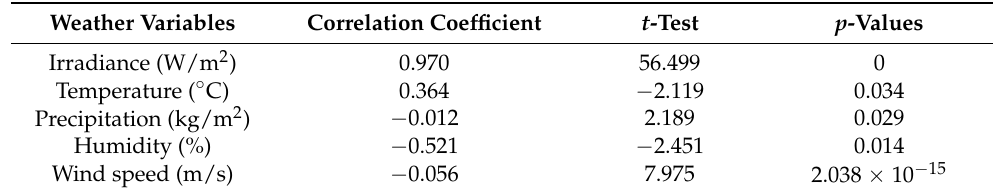
Table 2. The statistical test between weather features and PV power output. Weather